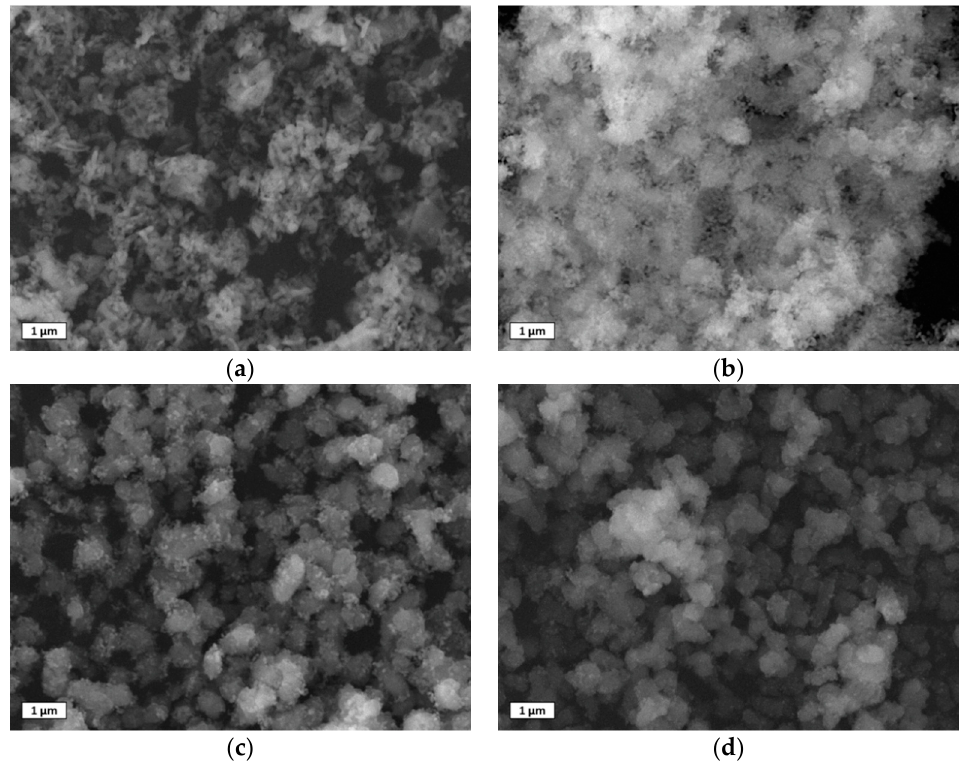
Figure 10. SEM images using secondary electron of used samples: (a) CZ, (b) CCZ40, (c) CCZ60, and (d) CCZ80.